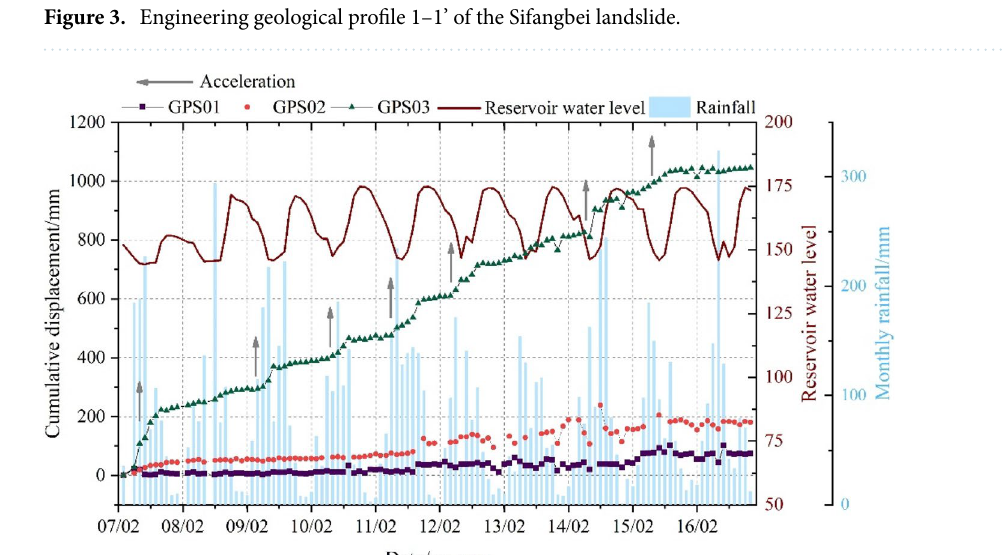
Figure 4. Monitoring data: rainfall, reservoir water level, and cumulative displacement of Sifangbei